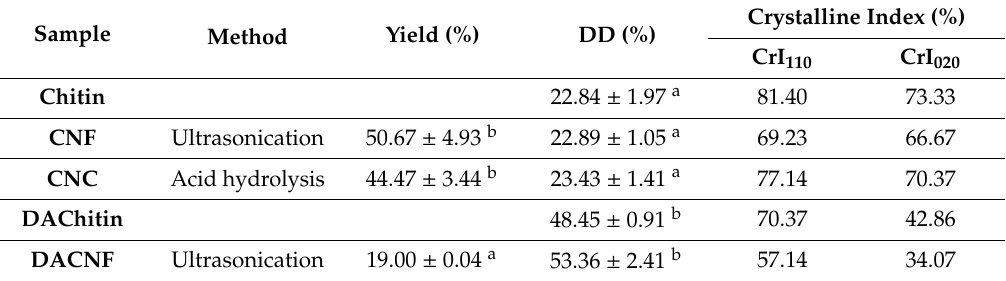
Table 1. The yield, degree of deacetylation (DD) and crystalline index of chitin, deacetylated chitin